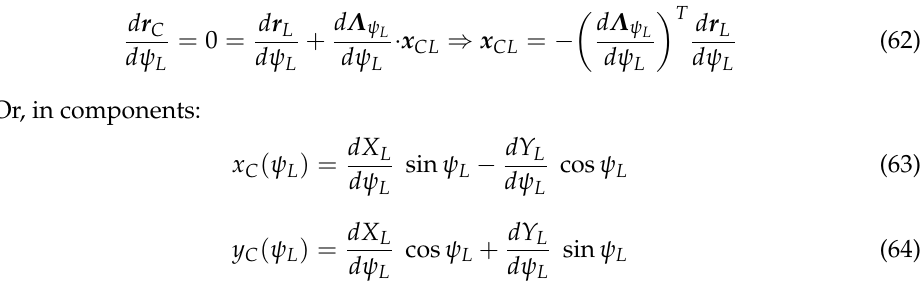
The coordinates 𝑥 𝐶 ,𝑦 𝐶 of the c.i.r., expressed with respect to the mobile frame are not modified during infinitesimal motion due to the rigidity of the mobile rigid body. The only variable terms are 𝑋 𝐿 ,𝑌 𝐿 and 𝒆 𝑥 (𝜓 𝐿 ),𝒆 𝑦 (𝜓 𝐿 ) , which are all functions of the final an-